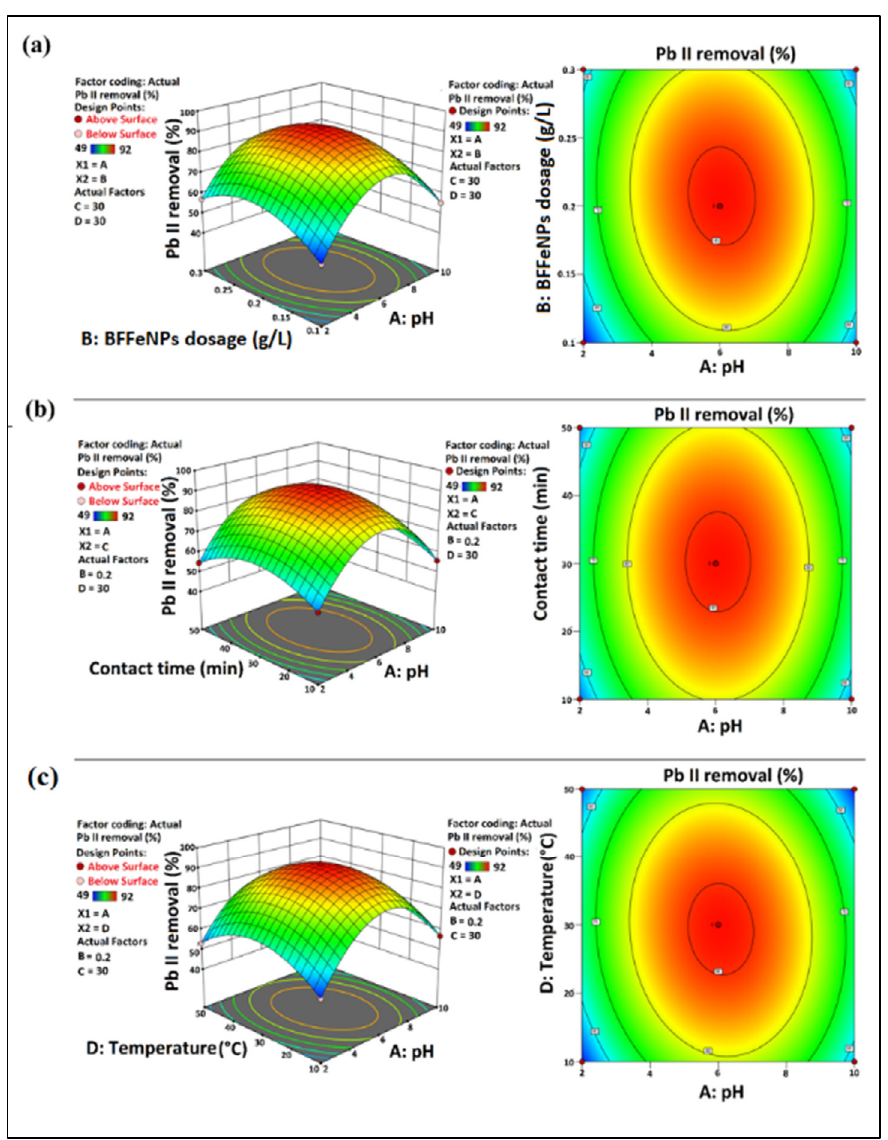
Fig. 5. Response surface 3D and contour plots showing the interactive effect between (a) pH and BFFeNPs dosage (AB), (b) pH and Contact time (AC), (c) pH and temperature (AD) during Pb (II)